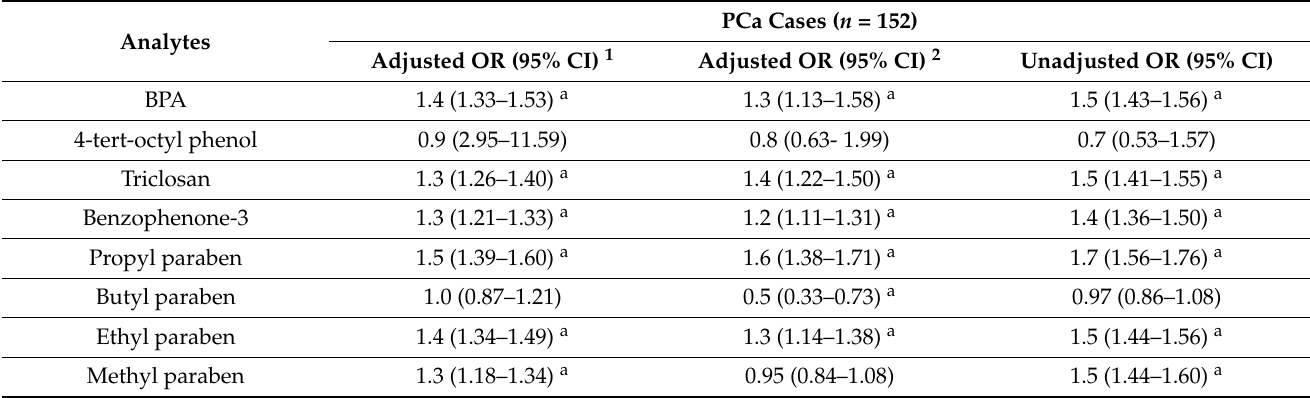
Table 6. Estimated odds ratios (95% CI) for risk of having PCa cases by the concentration of EP and PB levels in the urine samples of men ≥ 20 years of age; NHANES 2005–2015.